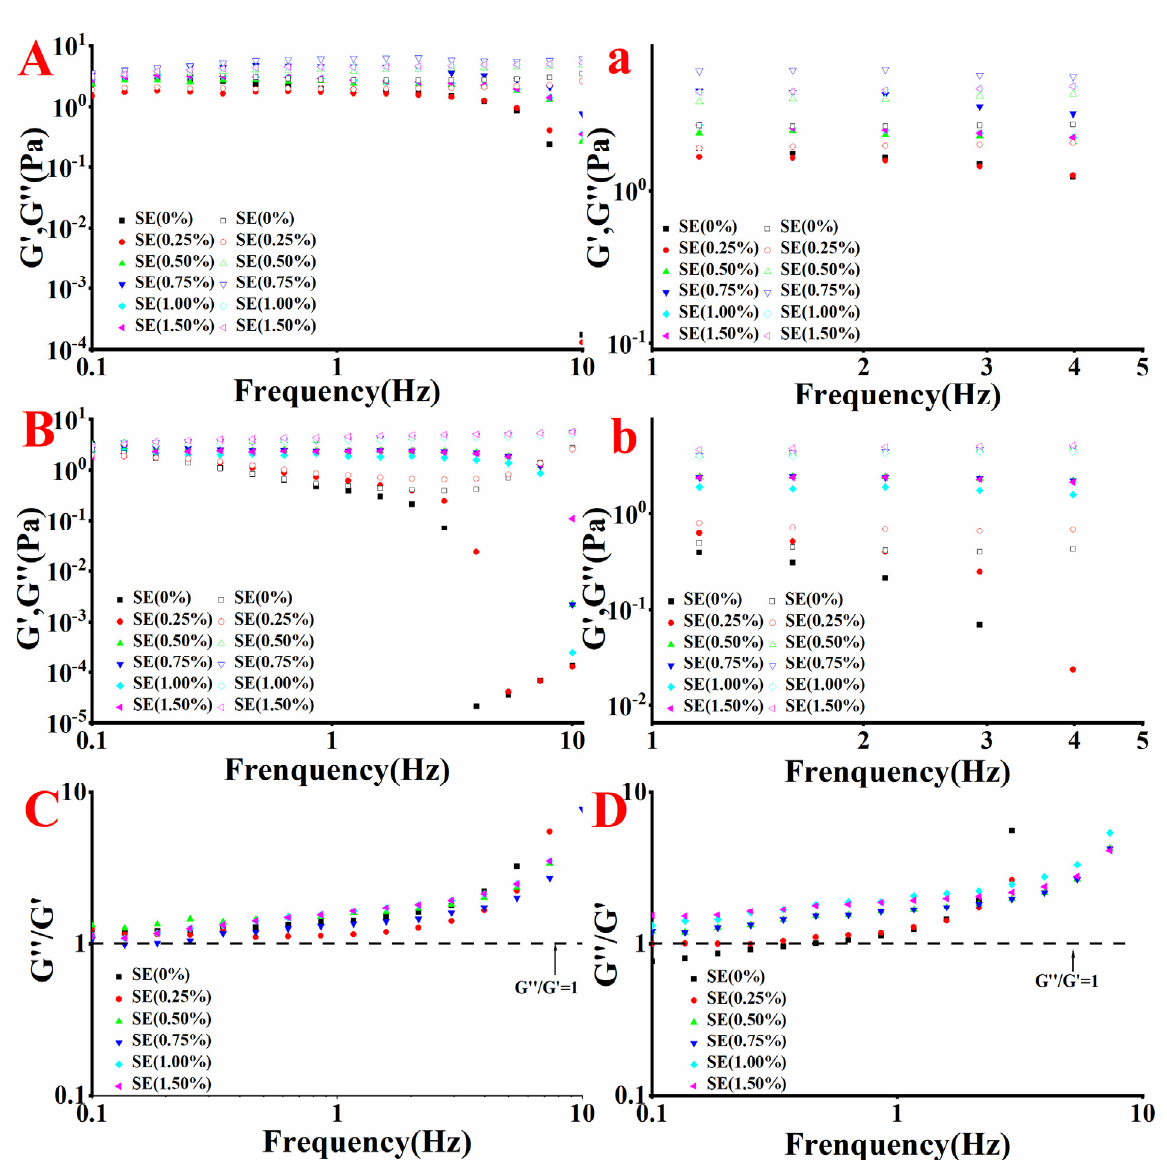
Figure 3. The changes of viscoelastic properties of the emulsions at different SE concentrations ( A ): SPI (the solid point is G’, the hollow point is G”); ( B ): WPI (the solid point is G’, the hollow point is G”); Figure ( a ) is partial enlarged view of Figure ( A ) at 1–5 HZ. Figure ( b ) is partial enlarged view of Figure ( B ) at 1–5 HZ. Value of the ratio of viscous modulus to elastic modulus of the emulsions at different SE concentrations (( C ): SPI; ( D ): WPI).